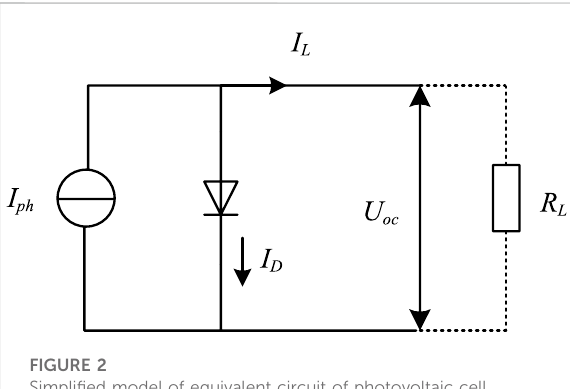
FIGURE 2 Simpli fi ed model of equivalent circuit of photovoltaic